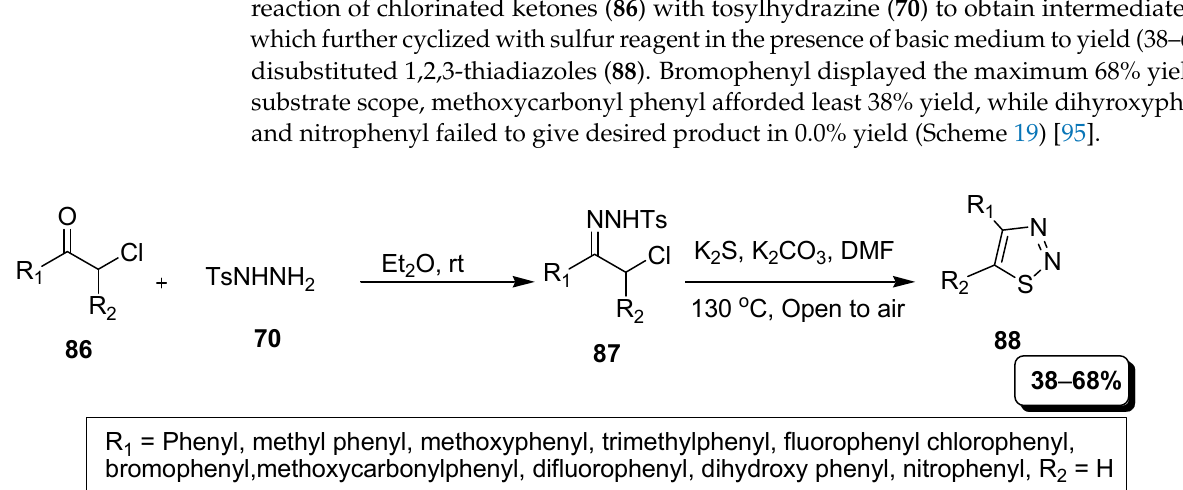
Scheme 19. Synthesis of 1,2,3-thiadiazoles from in situ generated azoalkenes with S 3• − via a cascade process.